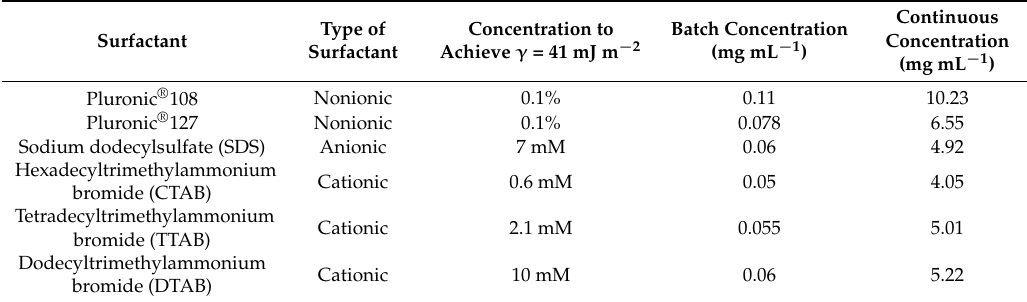
Figure 21. Concentration of graphene in aqueous dispersions achieved by the use of different surfactants, as estimated from UV–vis absorption measurements. Two surfactant concentrations are shown: 0.5% and 1.0% wt/vol. Inset figure-histogram showing the distribution of apparent flake thickness measured by AFM on 200 objects from dispersions stabilized by the non-ionic triblock copolymer P-123. Reproduced from [100]. Copyright Elsevier, 2011. Table 5. Production of aqueous graphene dispersions using different surfactants and addition methods